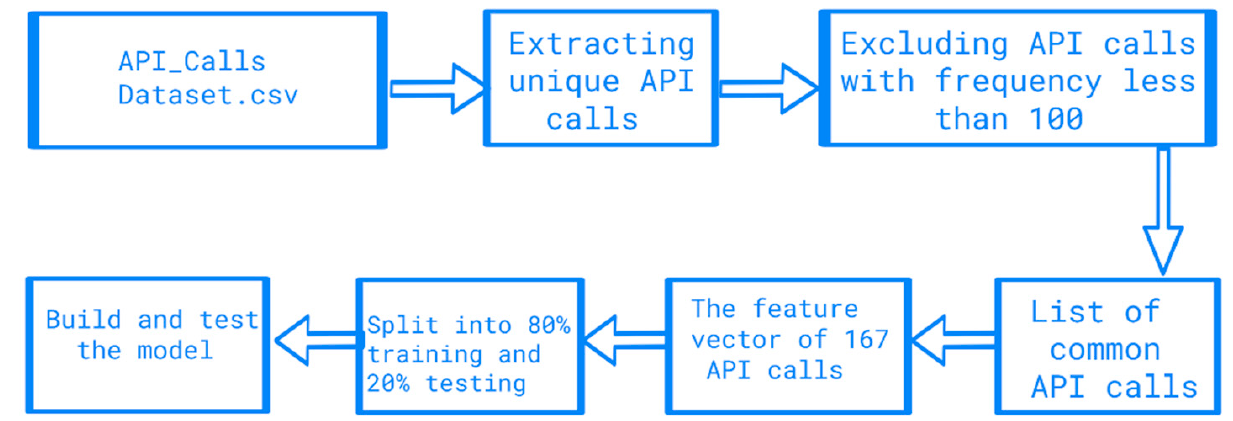
Figure 8. The workflow of malware detection using API call frequency.